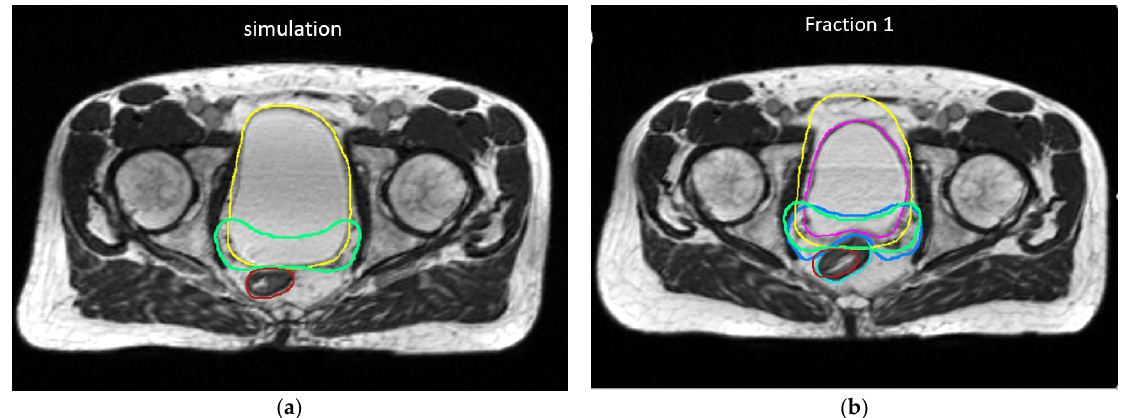
Figure 1. An example of CTV and OAR contours on ( a ) initial plan and ( b ) daily MRI on fraction 1 of a patient demonstrating relatively large interfractional shape variations in CTV and rectum and bladder. CTV: (Green–initial plan, blue–daily MR). Bladder: (yellow–initial plan, pink–daily MR); rectum (red–initial plan, cyan–daily MR). Table 1. Interfractional volume changes and shape variations as quantified by Dice Similarity